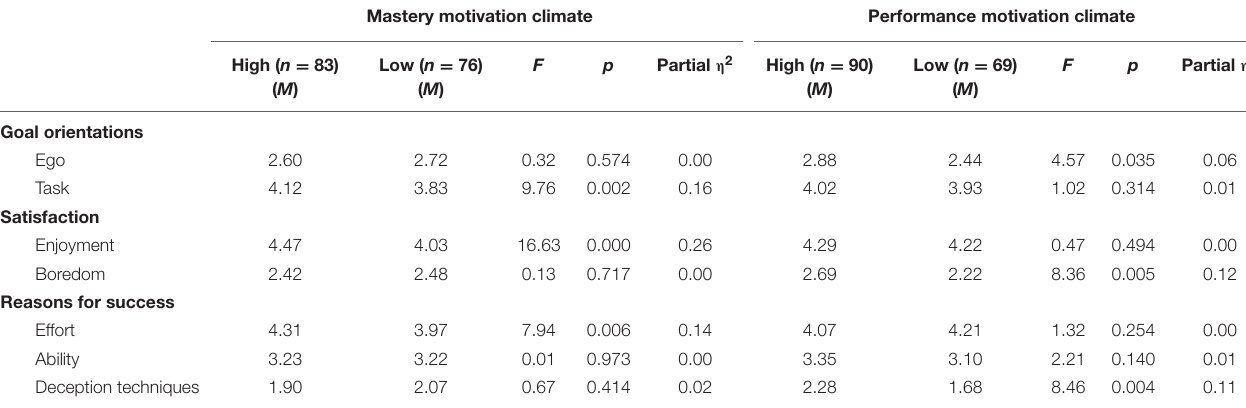
TABLE 2 | Univariate effect of perceived motivational climate on goal orientation, satisfaction, and reasons for success according to the level of perceived mastery and performance motivation climate.